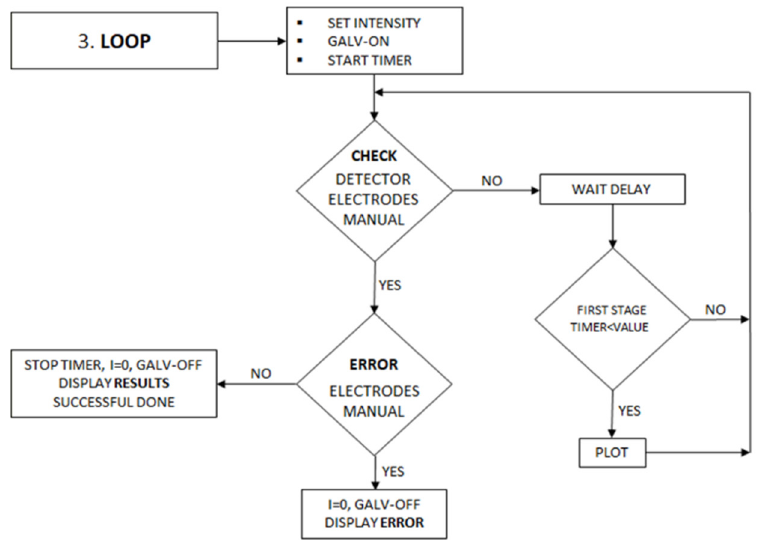
Figure 3. Flow diagram for the measurement and endpoint control. The error conditions are also verified: high resistance and emergency stop.